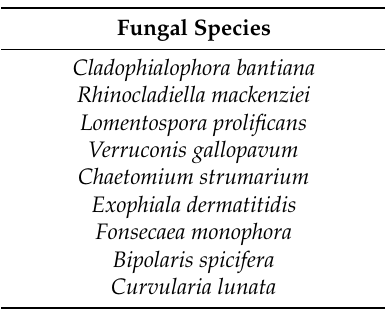
Table 1. Fungal species causing CNS